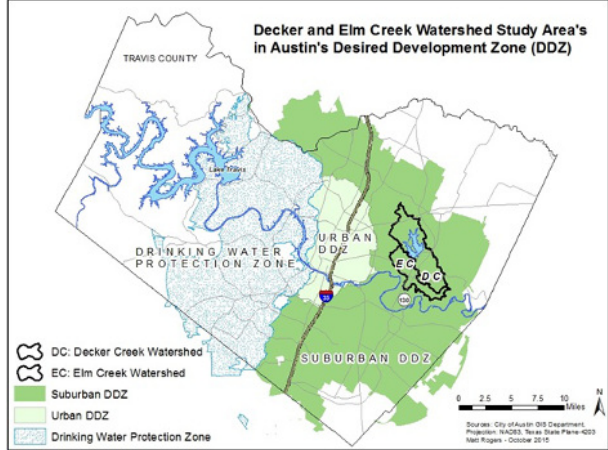
Figure 1. The Decker Creek and Elm Creek Watershed study areas, located in Austin, Texas in Travis County, re- side completely in the Suburban DDZ, an area promoted for growth and development by the City of